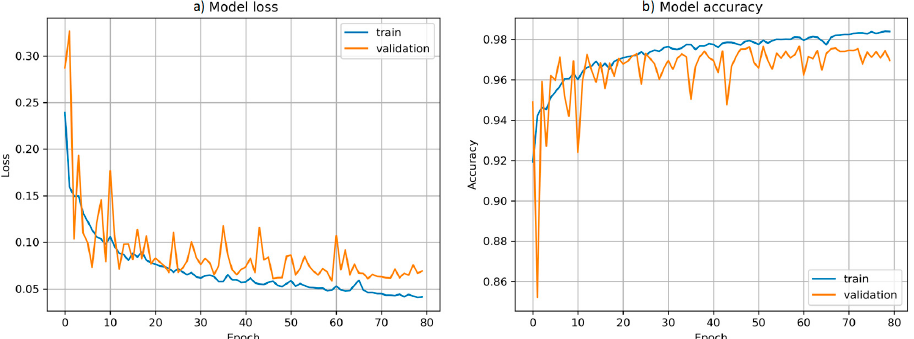
Figure 5. Training history of the final model indicating loss and accuracy for the training and validation dataset. The model received the BC3 bands as input and was trained until convergence on the augmented dataset. ( a ) Model loss; ( b ) model accuracy.